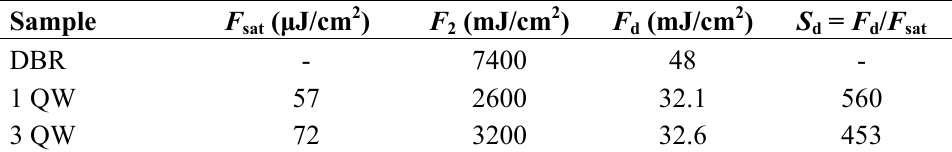
Table 4. Relevant parameters and damage thresholds of the samples with different absorber sections.